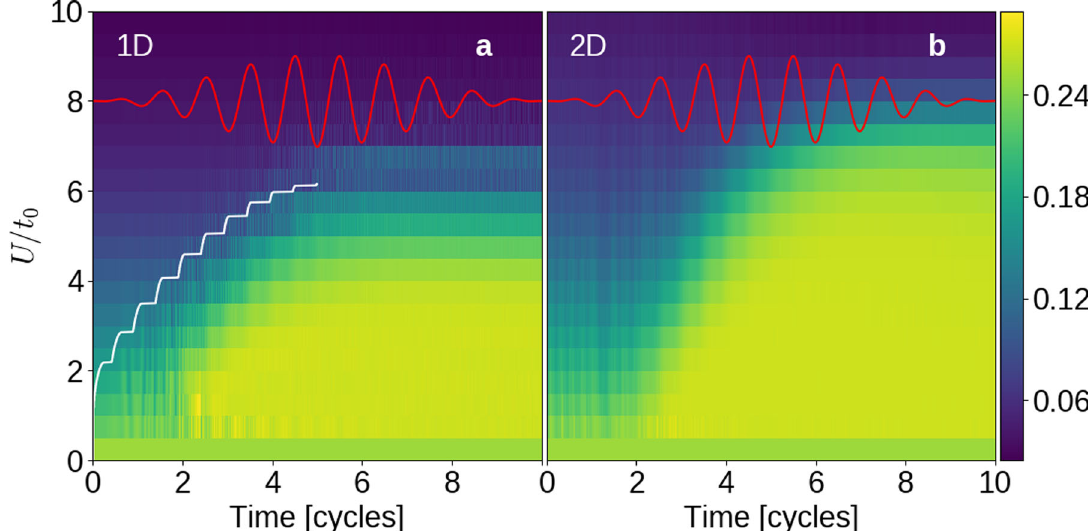
Fig. 1 Demonstration of photo-induced Mott transition. Plot shows the time-evolution of the doublon density in the 1D ( a ) and 2D ( b ) Hubbard models under the driving pulse with temporal pro fi le given in red, as U / t 0 is varied. Both systems are comprised of 12 site lattices, calculated by the exact propagation of the wave packet in time. The white line shows the time that the threshold fi eld E th is exceeded, using analytic expressions for the Mott gap and coherence length in the thermodynamic limit, available in 1D from the Bethe